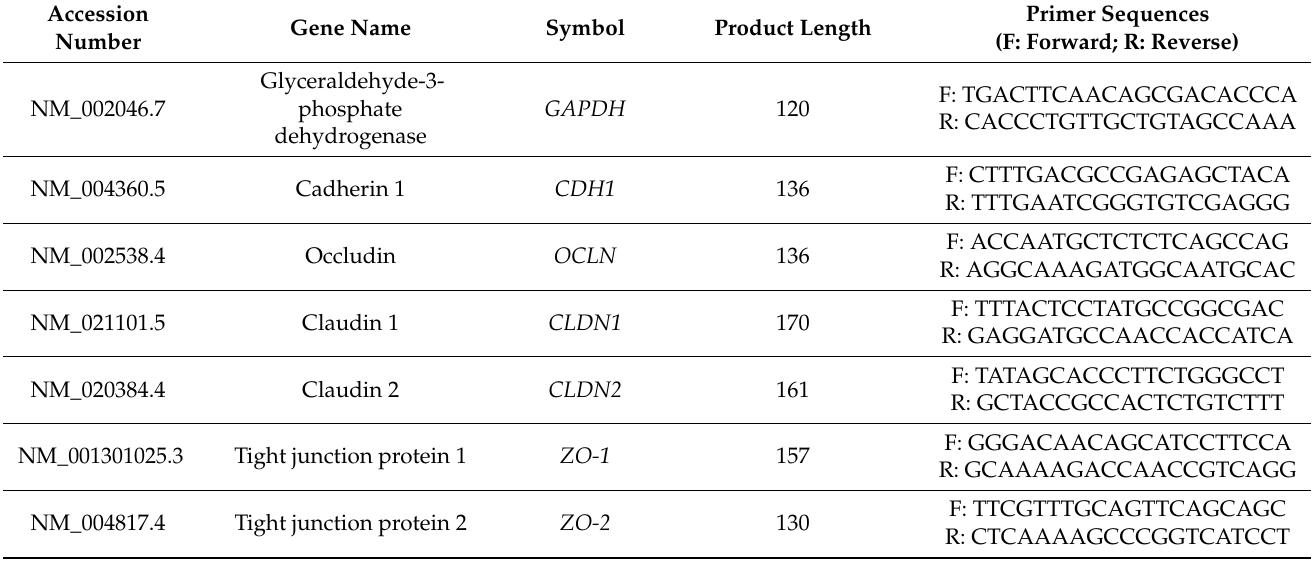
Table 1. Primer sequences used for